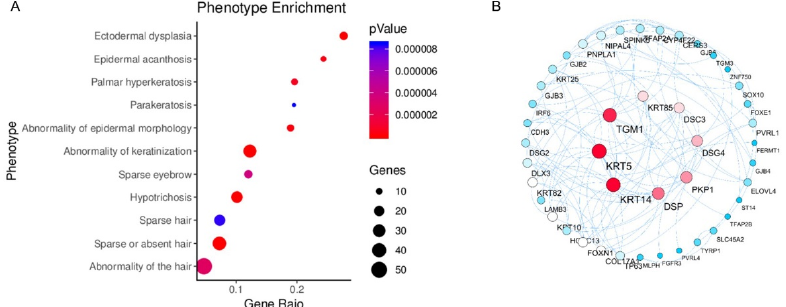
Figure 6. Gene enrichment and network analysis of the defective hair development phenotype. ( A ) phenotype enrichment of the defective hair development phenotype in cluster B; ( B ) the PPI net- work diagram of core genes.